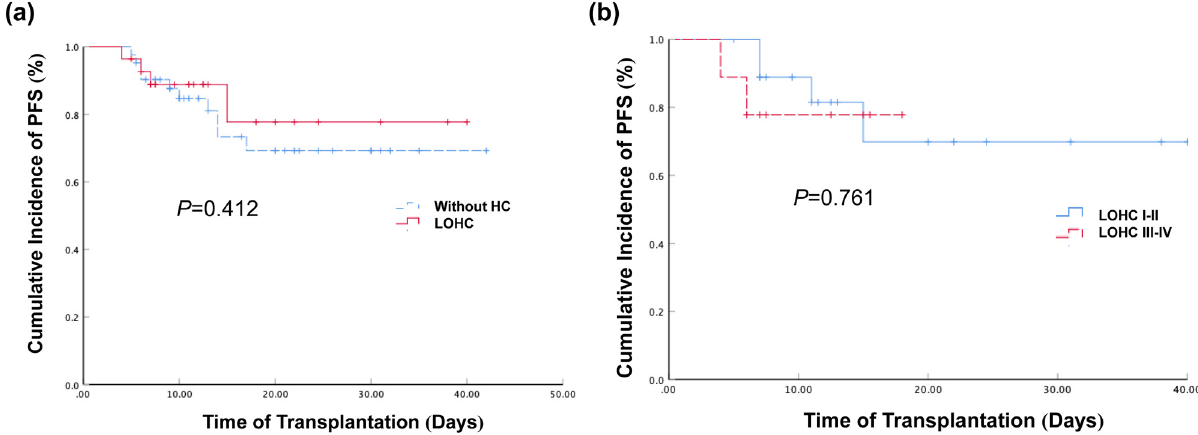
Figure 2: The cumulative incidence of PFS in patients with LOHC/without HC and patients with di ff erent LOHC grades. ( a ) The cumulative incidence of PFS in patients with LOHC and those without HC after haplo - PBSCT were 69.3% ( 95% CI: 52.6 – 85.9% ) and 77.7% ( 95% CI: 59.9 – 95.5% ) , respectively. The P value was 0.412. ( b ) The cumulative incidence of PFS in LOHC I – II and LOHC III – IV groups after haplo - PBSCT were 69.8% ( 95% CI: 43 – 96.6% ) and 77.8% ( 95% CI: 50.6 – 105% ) , respectively. The P value was